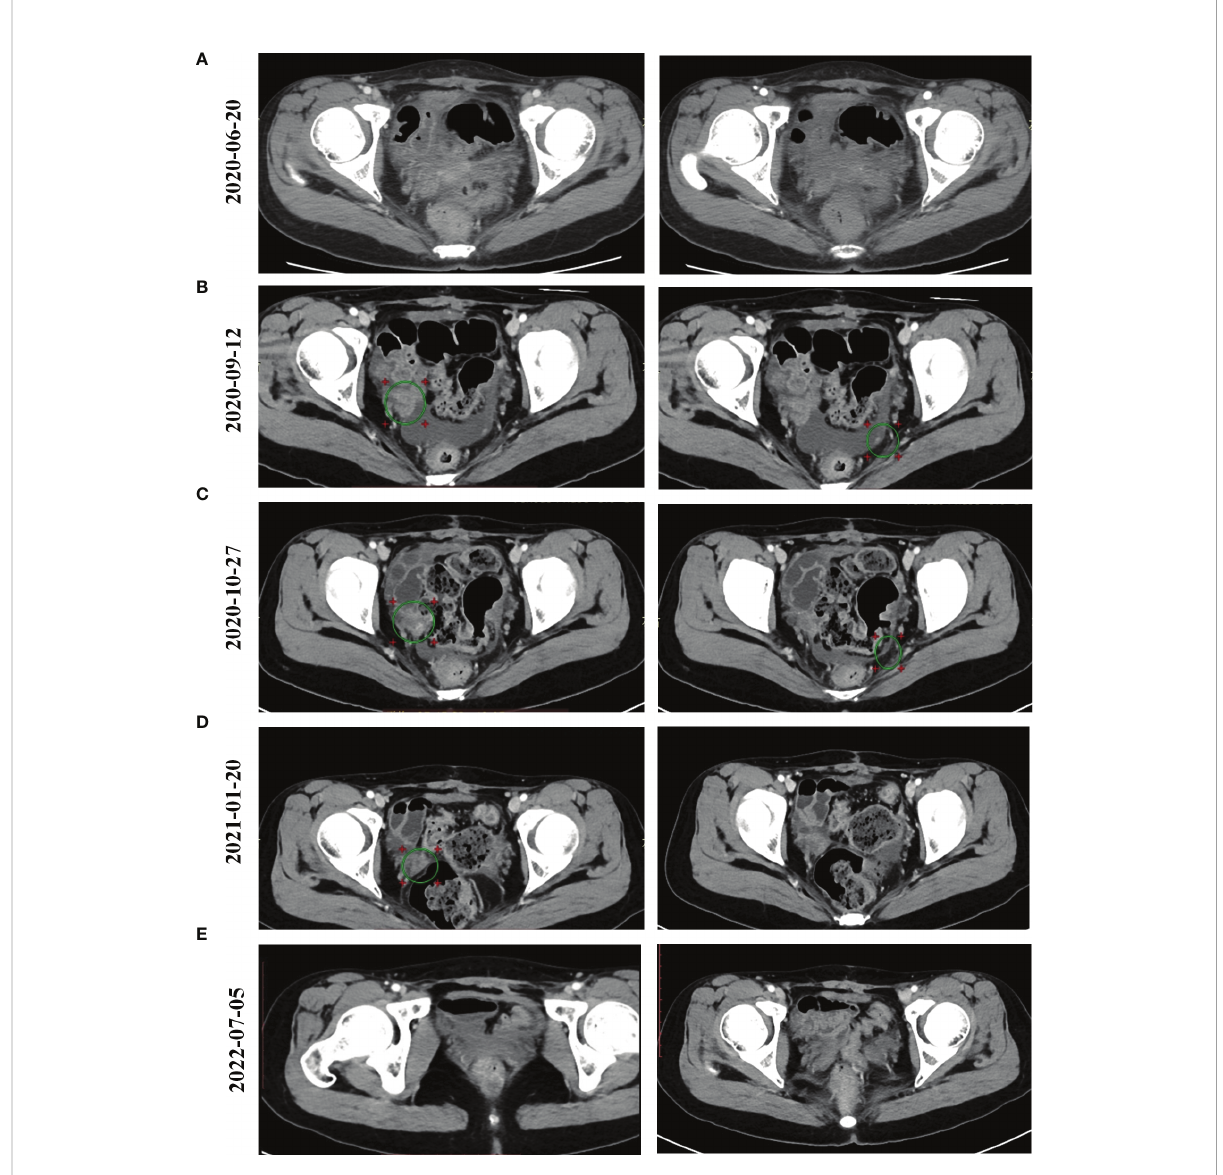
FIGURE 1 Computed Tomography (CT) images for our patient over the course of treatment. (A) The results of abdominal enhanced CT scan for the patient following two cycles of trastuzumab/pertuzumab/capecitabine therapy after the patient underwent radical surgery on 20 June 2020. (B) The results of abdominal CT scan for the patient following six cycles of trastuzumab/pertuzumab/capecitabine therapy on 12 September 2020. (C) The results of abdominal CT scan for the patient following two cycles of pyrotinib/bevacizumab/capecitabine therapy on 27 October 2020. (D) The results of a PET-CT scan for the patient following six cycles of pyrotinib/bevacizumab/capecitabine therapy on 20 January 2021. (E) Positron Emission Tomography-CT (PET-CT) scan showed our patient ’ s condition on 5 July